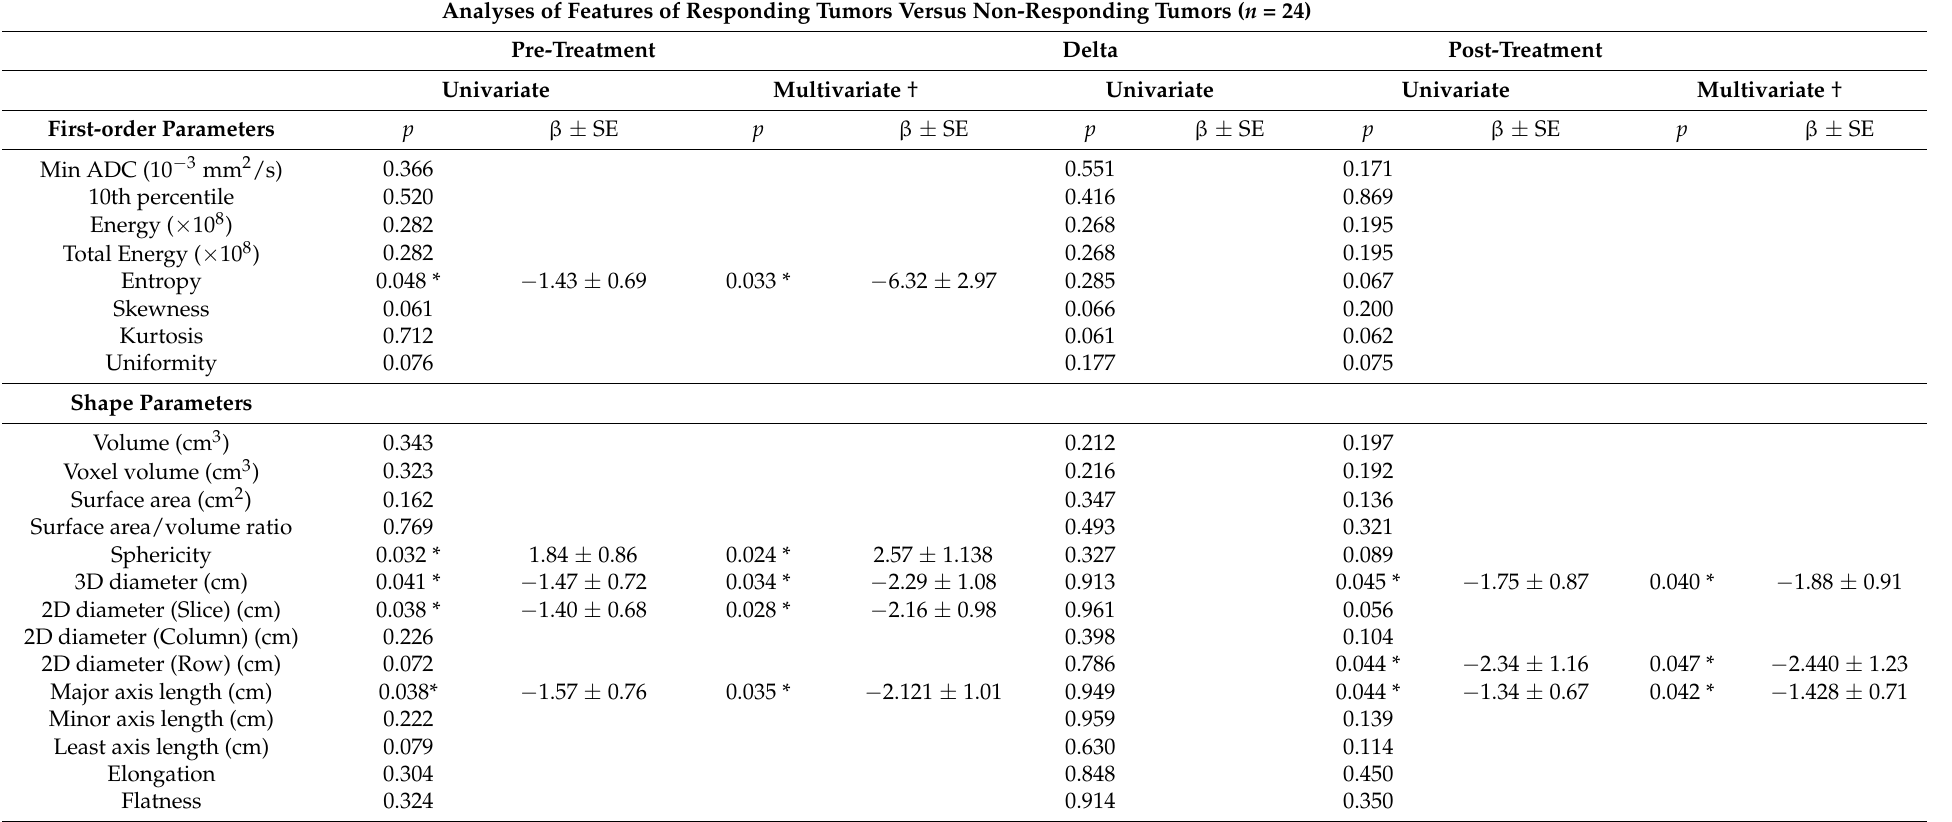
Table 3. Features analyses of responder groups at pre-treatment, post-treatment, and delta time